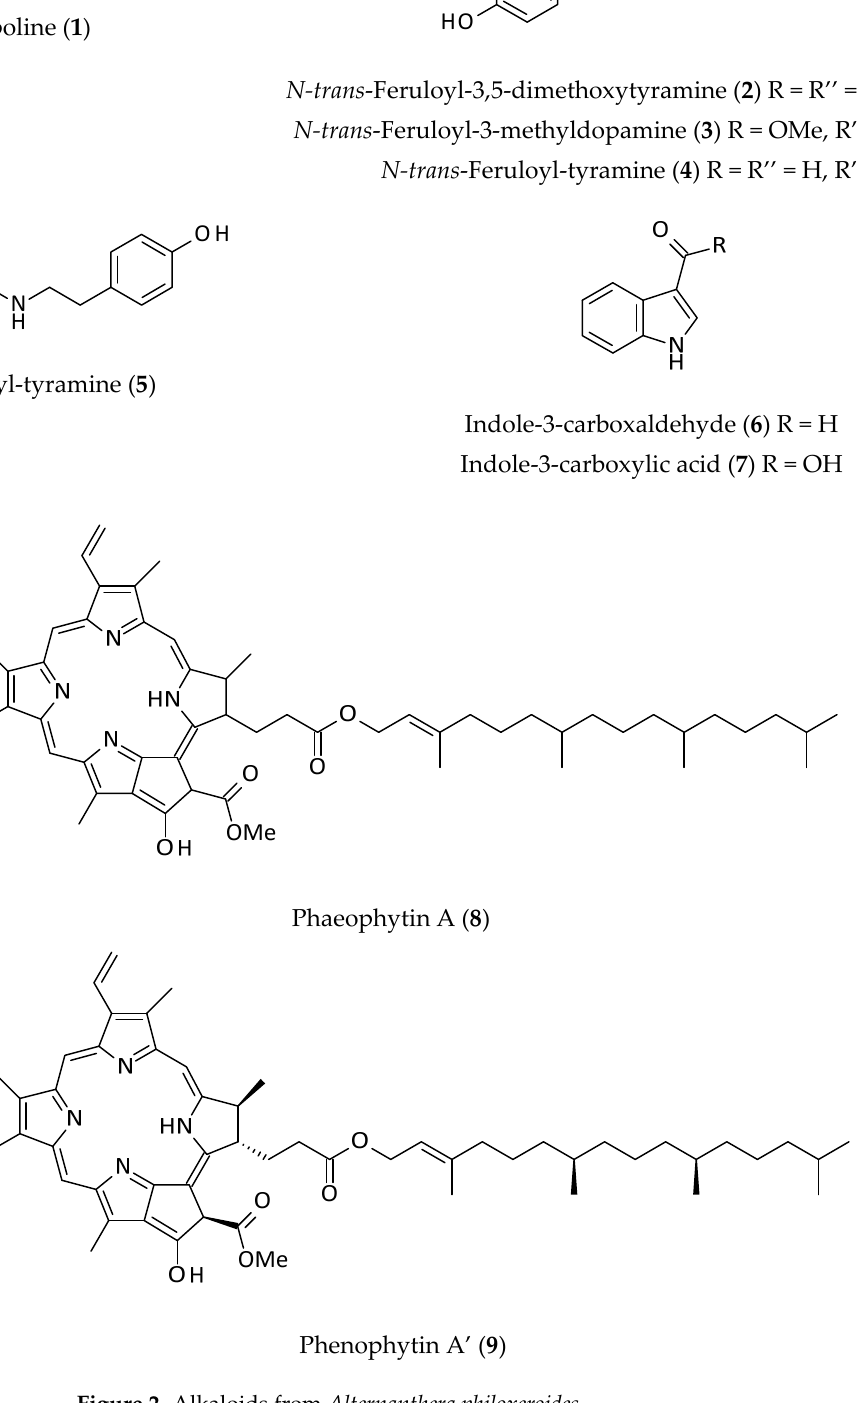
Figure 2. Alkaloids from Alternanthera philoxeroides . Phaeophytins or pheophytins ( 8 and 9 ) are chlorophyll molecules without a magne- sium ion (Mg 2+ ). They are essential parts of photosynthesis in plants, and act as the first electron carrier intermediate in the electron transfer pathway of the photosystem II path- way. β -Carboline ( 1 ), reported from the aerial parts of A. philoxeroides [16], has an indole unit fused with a six membered heteroaromatic ring (pyridine ring), and is the basic struc- ture of ca. 100 alkaloids with various pharmacological properties. This group of com- pounds are well distributed in prokaryotes, plants, and animals. Many β -carboline ana- logues can intercalate into DNA and can inhibit cyclin dependent kinase (CDK), topoiso- merase, and MAO [21]. These alkaloids also interact with benzodiazepine and 5-hydroxy- serotonin receptors, and possess anticonvulsant, antimicrobial, antitumour, antiviral, an- tiparasitic, anxiolytic, hypnotic, and sedative properties [22]. 2.2. Anthraquinones Anthraquinones, also known as anthracenedione or 9,10-dioxoanthracene, are tricy- clic aromatic compounds based on the anthracene skeleton [23]. Anthraquinones form a large group of pharmacologically active phytochemicals found in various plants (e.g., Aloe , Cascara, Cassia, Frangula, and Senna species). In plants, they often occur in their gly- cosidic forms. Three anthraquinones, 2-hydroxy-3-methylanthraquinone ( 10 ), rubiadin ( 11 ), and rubiadin-1-methyl ether ( 12 ) (Figure 3), were isolated from an ethyl acetate (EtOAc) extract of the aerial parts of A. philoxeroides by repeated column chromatography on silica gel [12]. None of these anthraquinones is particularly unique to this plant and can be found in other plants. 2-Hydroxy-3-methylanthraquinone ( 10 ) is found in various other Chinese medical plants (e.g., it was isolated as an anticancer principle from Hedyotis difffusa ) [24]. Similarly, bioactive rubiadin ( 11 ) and its derivatives are also found in other plants (e.g., Morinda citrifolia and Rubia cordifolia ) [25,26]. It can be noted that rubiadin ( 11 ), which fits the Lipinski’s rule of five for drug-likeness properties, is known to possess an- tibacterial, anticancer, antidiabetic, antifungal, anti-inflammatory, antimalarial, antioxi- dant, antiviral, hepatoprotective, and neuroprotective properties [26]. Natural anthraqui- nones usually bind to serum albumin, DNA, and glutathione (GSH) [27,28].